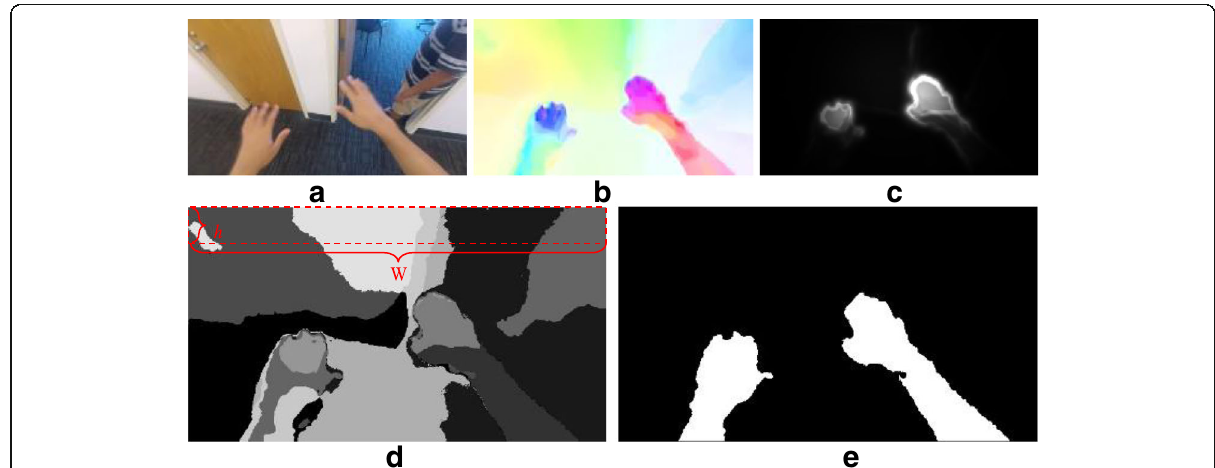
Fig. 3 Initialize hand label based on ego-saliency. a – e are original image, optical flow to the next frame, motion saliency of b , clustering result of b with non-interactive border labeled in red, and estimate hand